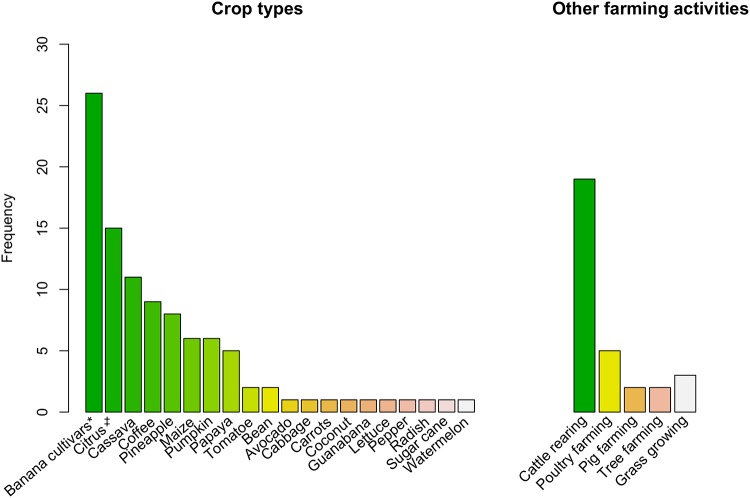
Main crop types and other farming activities as established during the socio-economic valuation questionnaire.Total sample n = 53. (*) Indicates a variety of grown banana cultivars (e.g. Guinean, green bananas, plantain) and (‡) a variety of citrus (e.g. oranges, lemons, mandarins).